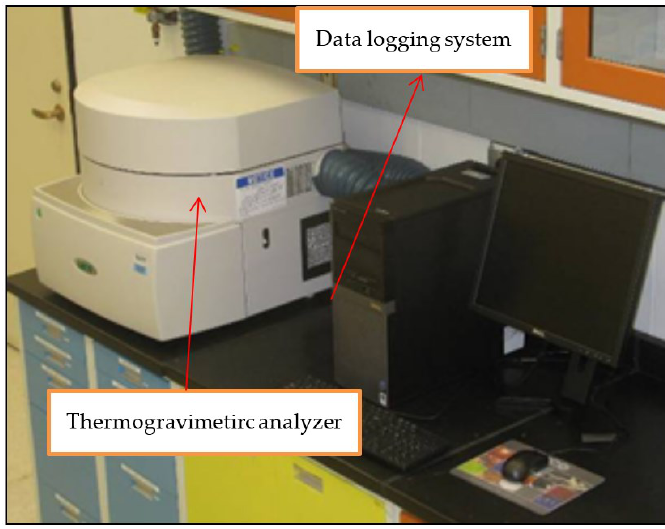
Figure 2. LECO Model 701 thermogravimetric analyzer [6]. Table 1. Methods to measure the chemical properties and higher heating values.